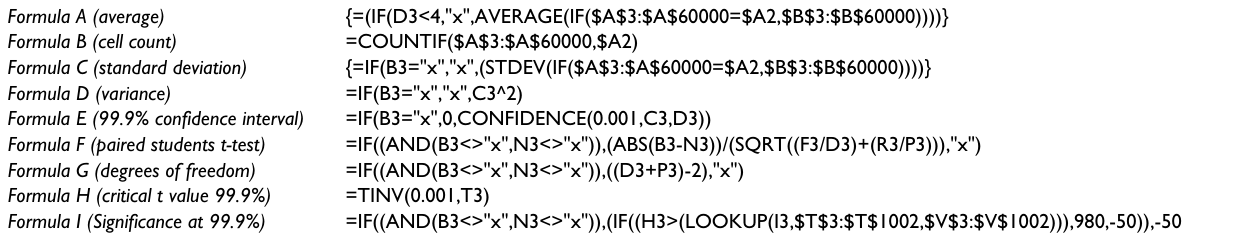
Table 1: Excel Formulae used in spreadsheet analysis Formula A